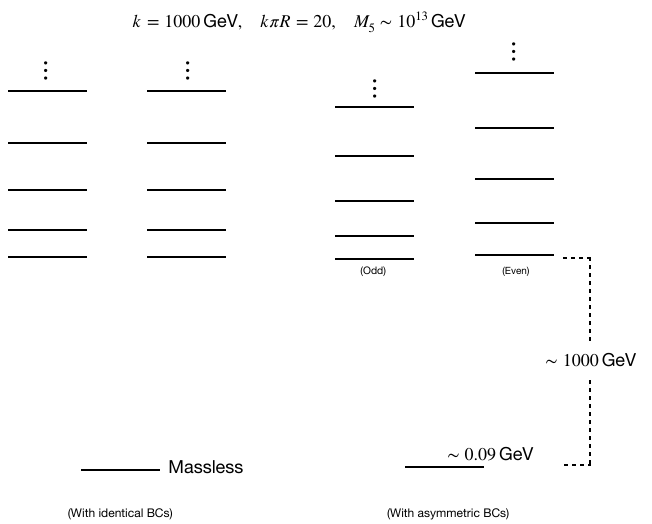
Figure 3 . Schematic representation of the first few KK levels in the case of identical (left) and asymmetric (right) boundary conditions for a benchmark parameter